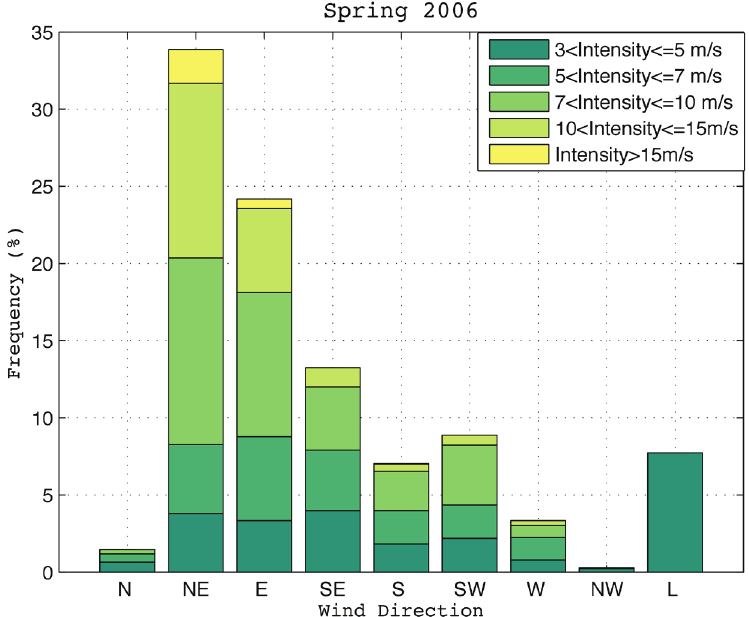
Figure 8 - Wind intensity frequency during the spring of 2006 from the Pilot